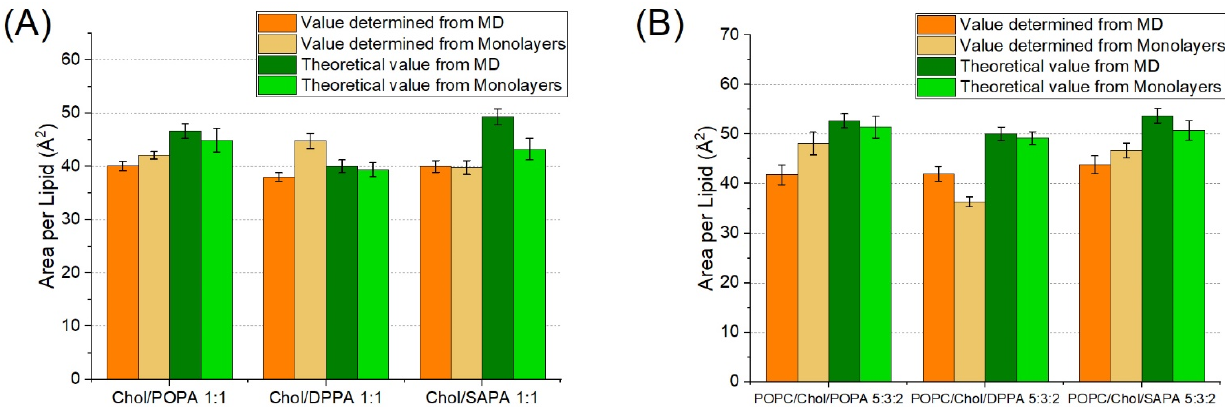
Figure 4. ( A ) Effect of PA on Chol membranes and ( B ) effect of PA on POPC/Chol membranes in APL determination for both simulation and experimental approaches. Theoretical values are determined based on values from single-component systems multiplied by a factor corresponding to molar concentration on the membrane (Equation (3)).